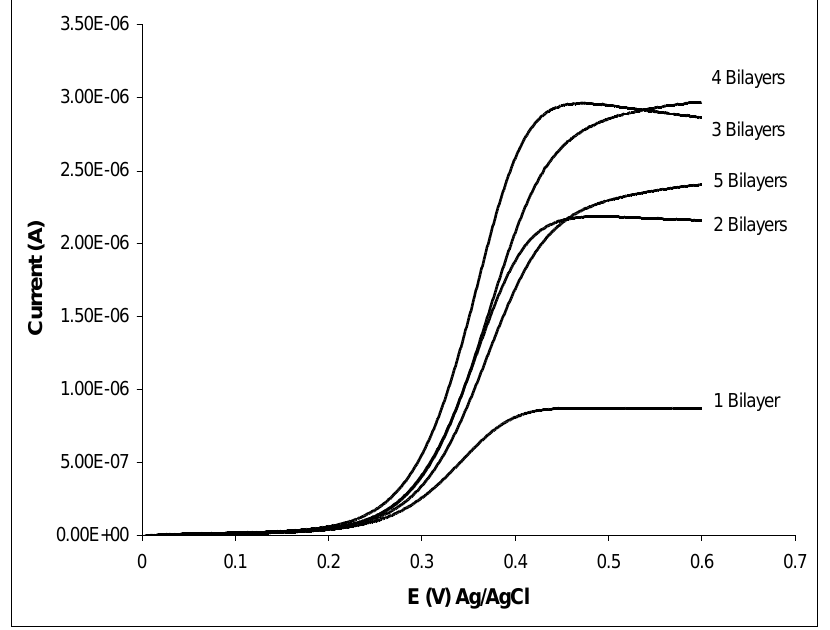
Figure 2. Electrode response to multiply bilayers of poly(allylammonium)